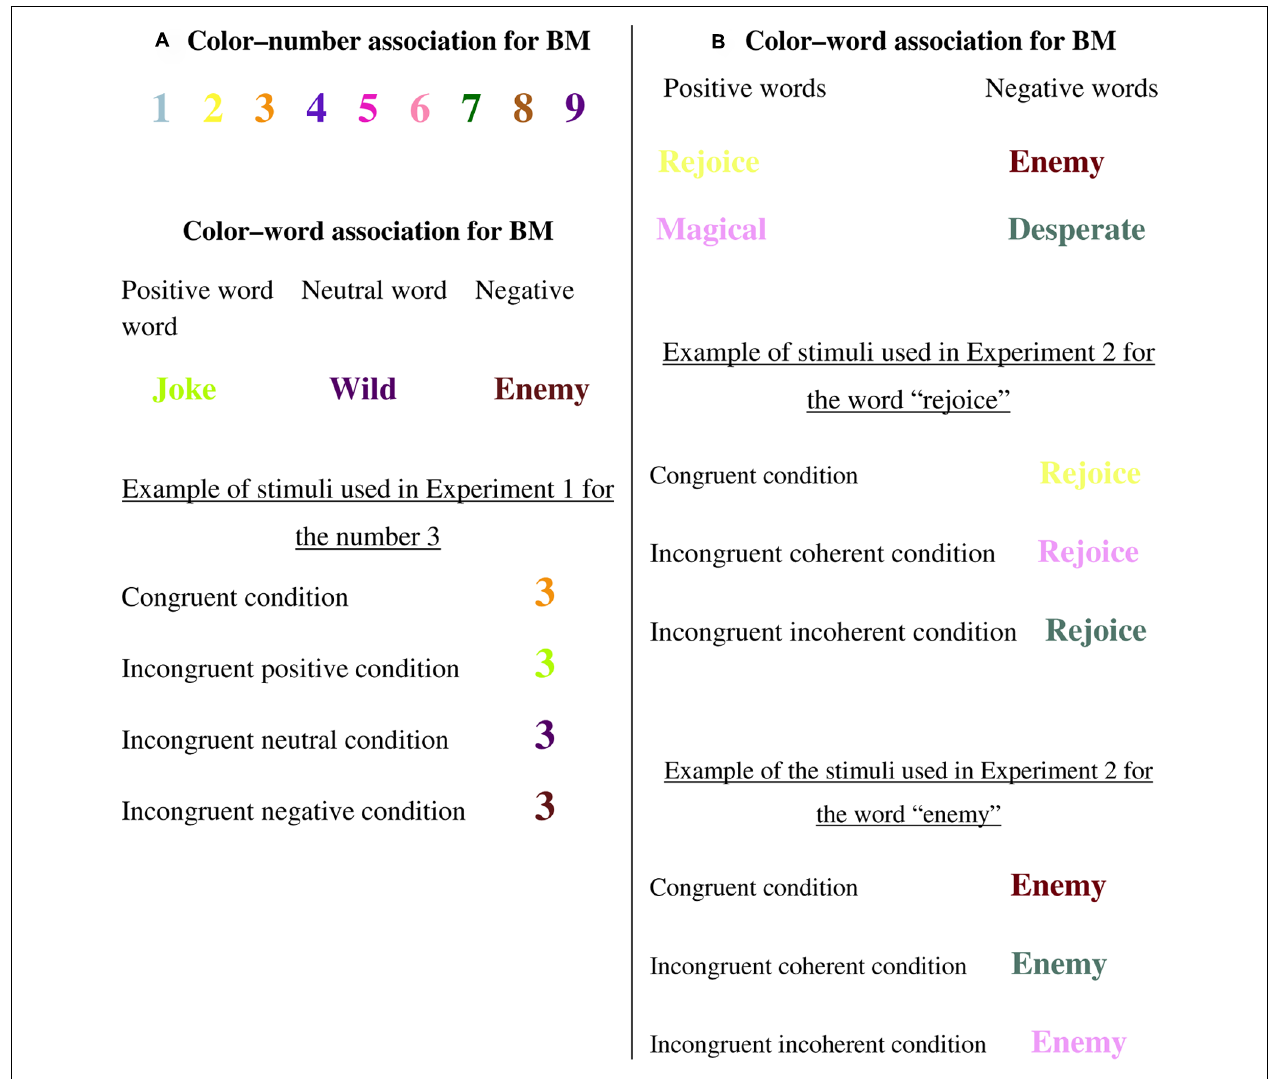
FIGURE 1 | (A) Examples of color–number and color–word associations for BM and stimuli in Experiment 1. (B) Examples of color–word associations for BM and of stimuli in Experiment 2.